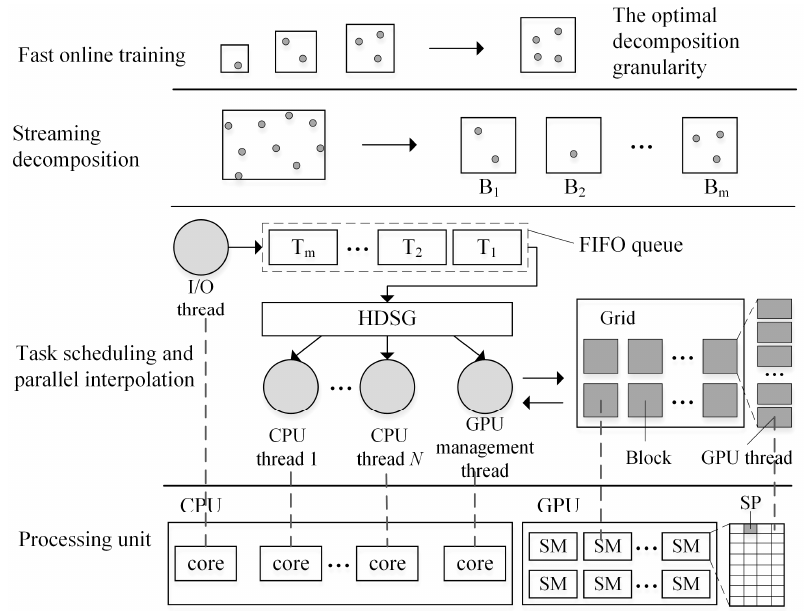
Figure 3. The framework of the hybrid parallel interpolation.